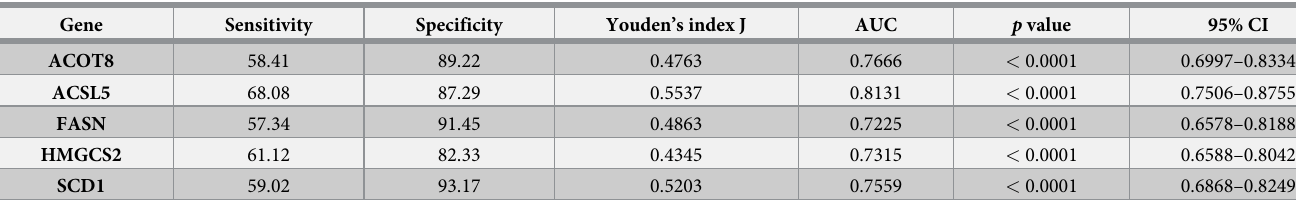
Table 2. Diagnostic performance of lipogenic genes in